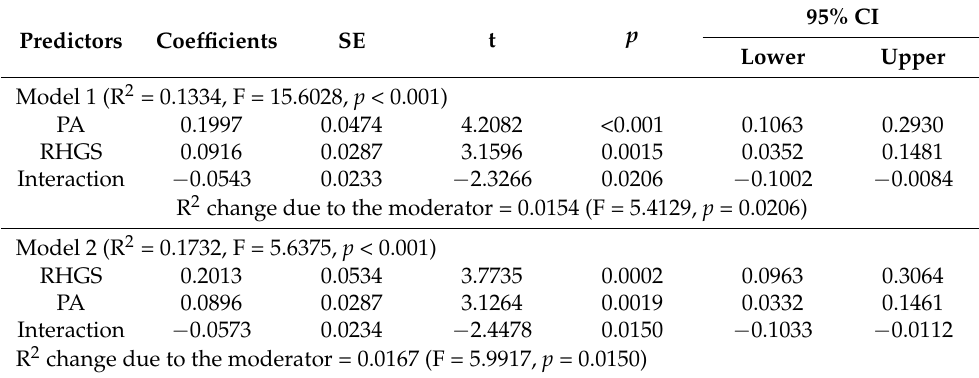
Table 4. Moderation analysis of relative handgrip strength (RHGS) in the relationship between physical activity (PA) and health-related quality of life.